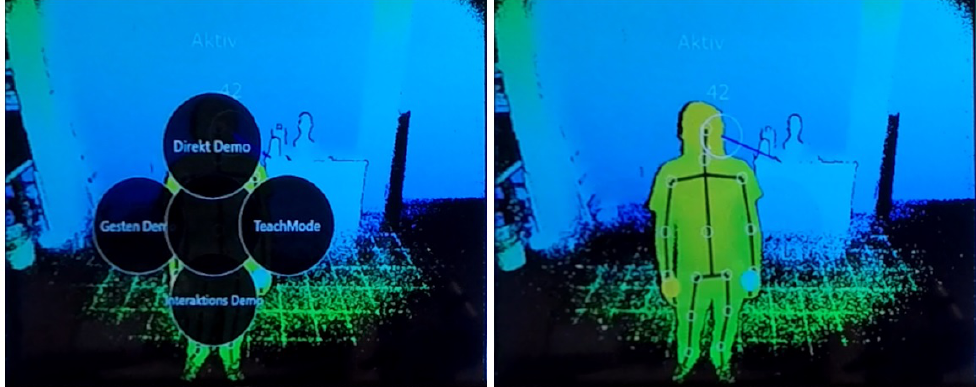
Figure 8. Attention detection: interaction is disabled when the user looks